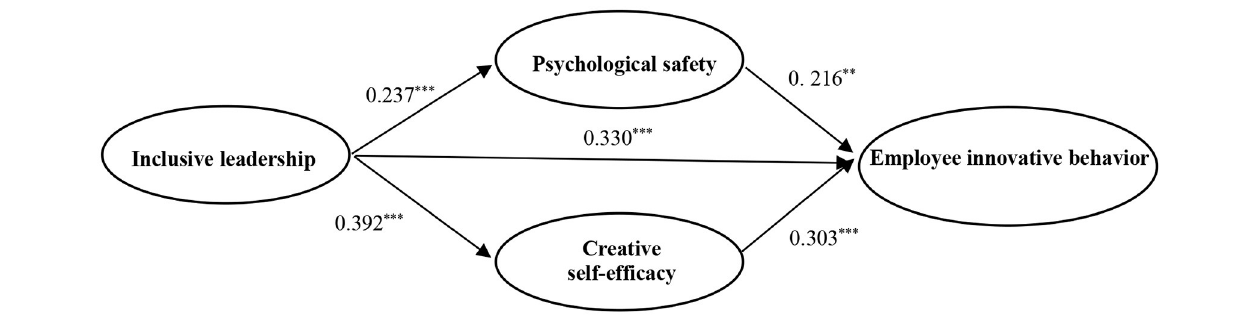
FIGURE 2 | Results of theoretical model by using Mplus. N = 418, ** p < 0.01, *** p < 0.001. Standardized path coefficients are